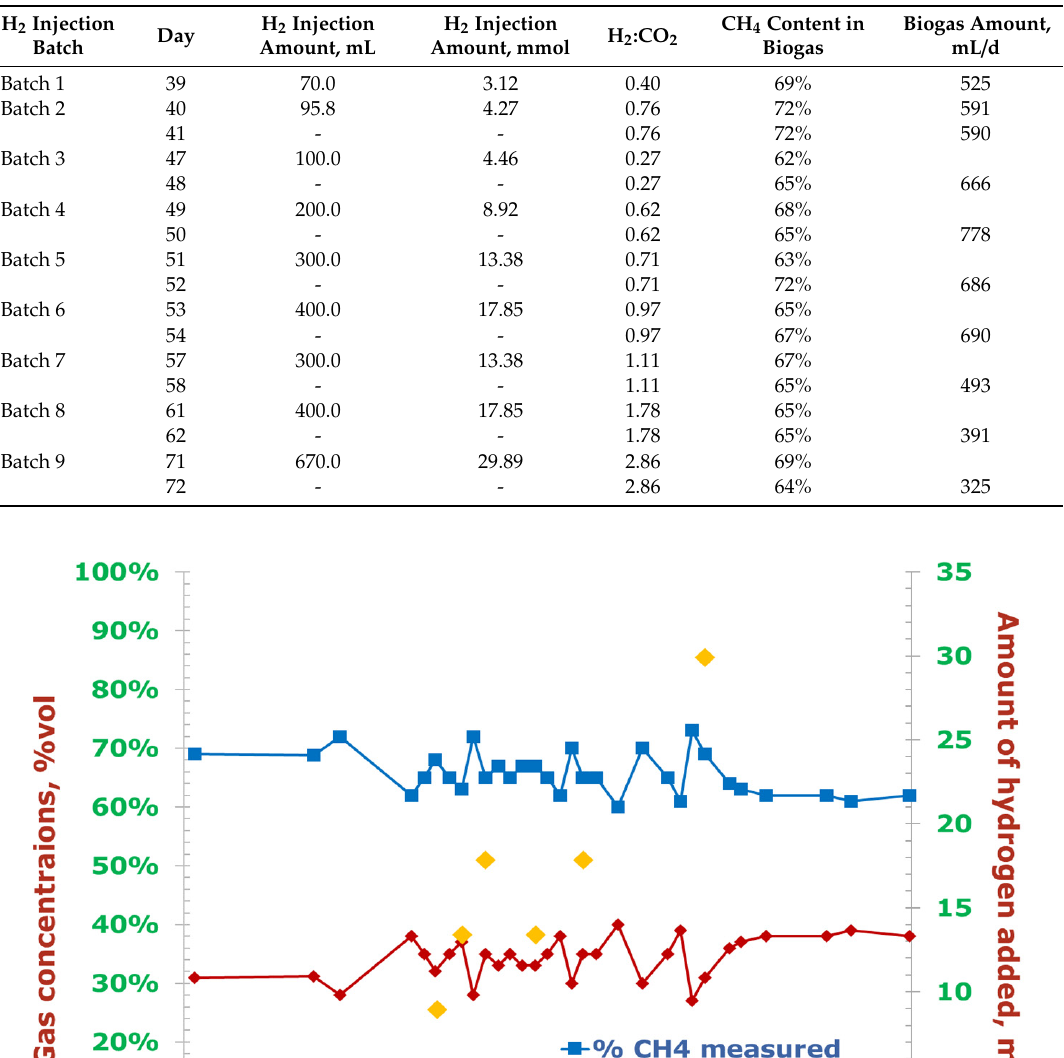
Table 3. H 2 injection strategy with corresponding methane content in biogas (methane content values after 24 h of H 2 injections are highlighted with underlined numbers).